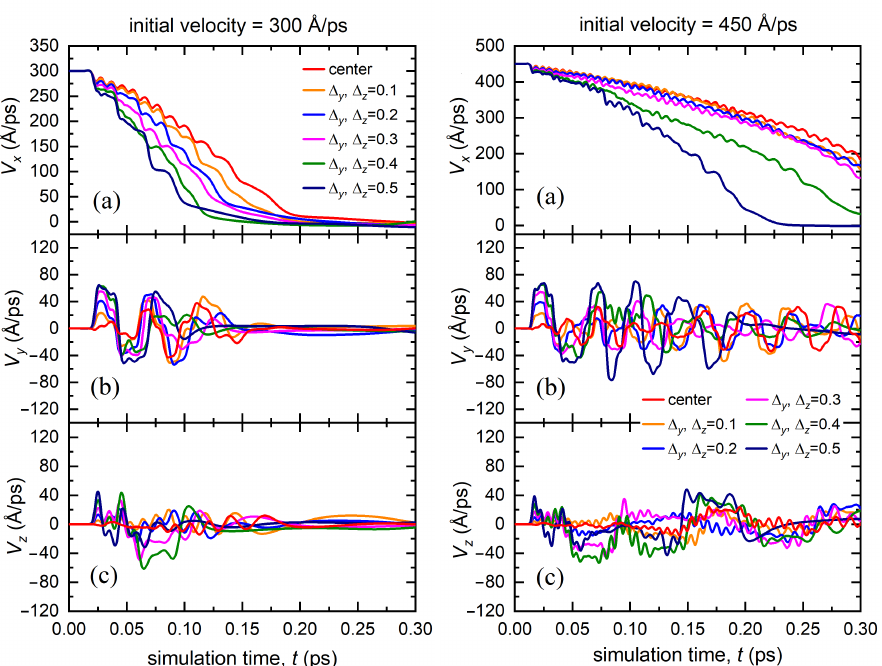
Figure 4. Dependence of the velocity components of the bombarding atom ( a ) V x , ( b ) V y , ( c ) V z on the simulation time calculated for various displacements of the atom along the y and z axes from the center of the octahedral channel (case III). The results are presented for two values of the initial velocity of the bombarding atom excited according to scenario two: 300 Å/ps (left panel) and 450 Å/ps (right panel).